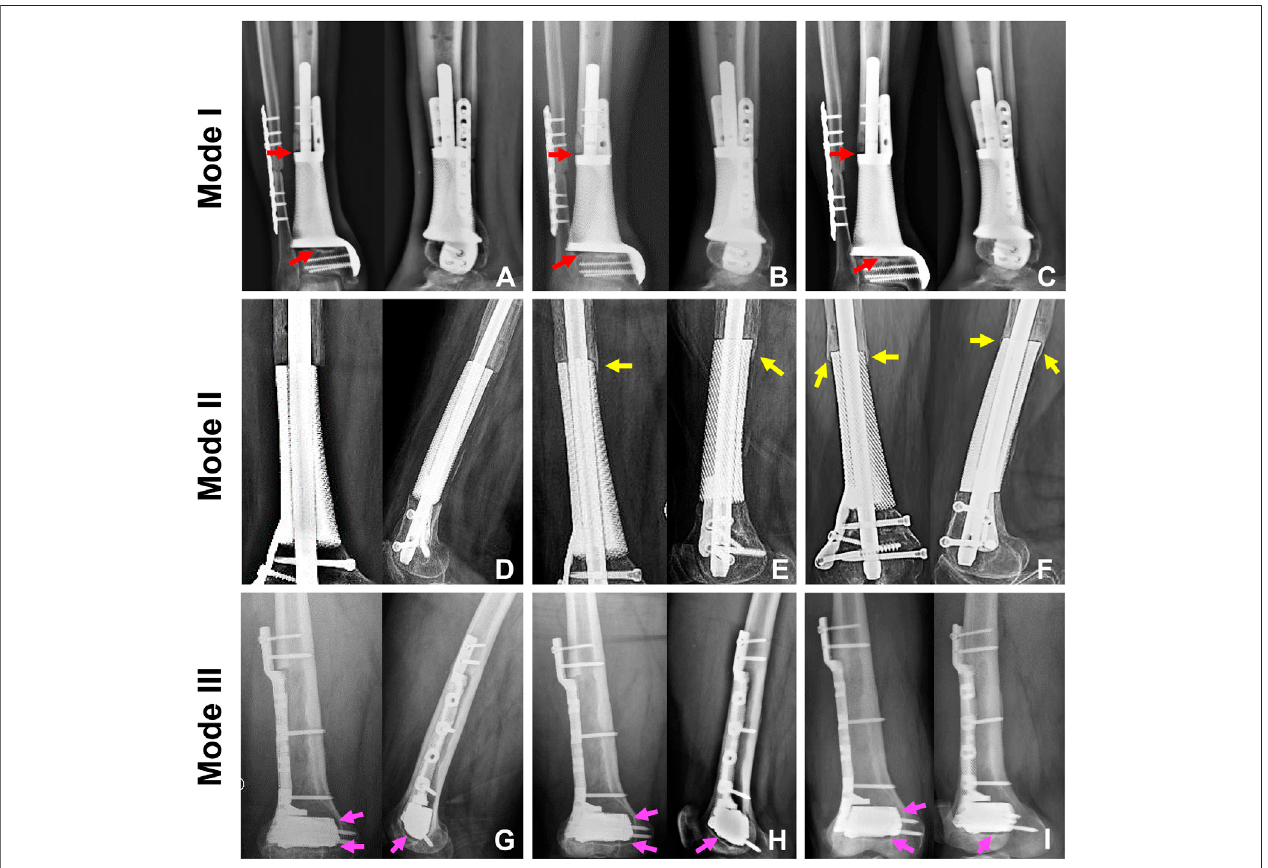
FIGURE7| Thestateofprosthesis ’ sstabilityandnewboneregenerationinthreegroups.ForModeI,thetypicalpatientwasa65-year-oldmalewhosuffereddistal tibial metaphyseal defect due to osteomyelitis. Along with his postoperative X-rays at 1 (A) , 7 (B) , and 22 (C) months, we could observe the stable location of both prosthesis and screws. The low-density gap at bone-prosthesis interface gradually blurred but not disappeared as directed by the red arrows. For Mode II, the typical patientwasa67-year-oldfemalewhosuffereddistalfemoralmetaphysealdefectduetoosteomyelitis.AlongwithherpostoperativeX-raysat1 (D) ,9 (E) and25 (F) months, we could observe the stable location of prosthesis, nail and screws. Besides, new bone continuously regenerated around the prosthesis as directed by the yellow arrows. For Mode III, the typical patient was a 26-year-old male who suffered distal femoral partial metaphyseal defect due to osteomyelitis. Along with his postoperative X-rays at 1 (G) , 5 (H) and 14 (I) months, we could observe the stable location of both prosthesis and screws. The low-density gap at bone-prosthesis interface existed persistently as directed by the pink arrows.